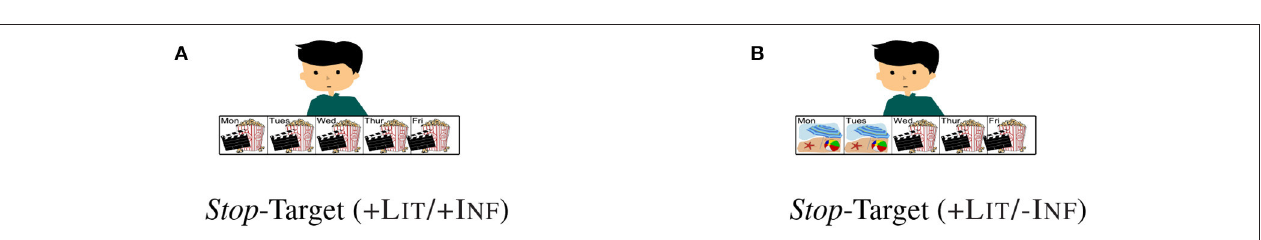
FIGURE 2 | Target pictures for stop conditions for a sentence like (39): “ + L IT / + I NF ” (A) and “ + L IT / − I NF ” (B)